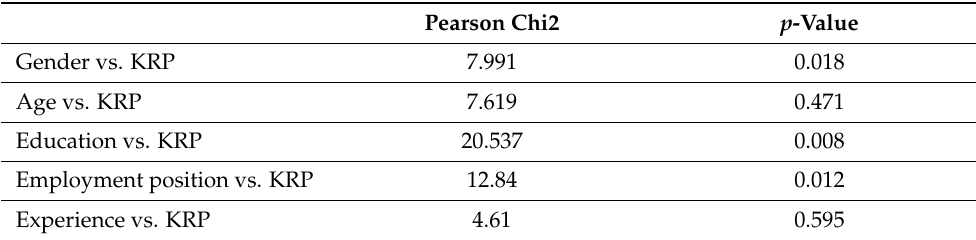
Table 3. Chi-squared test